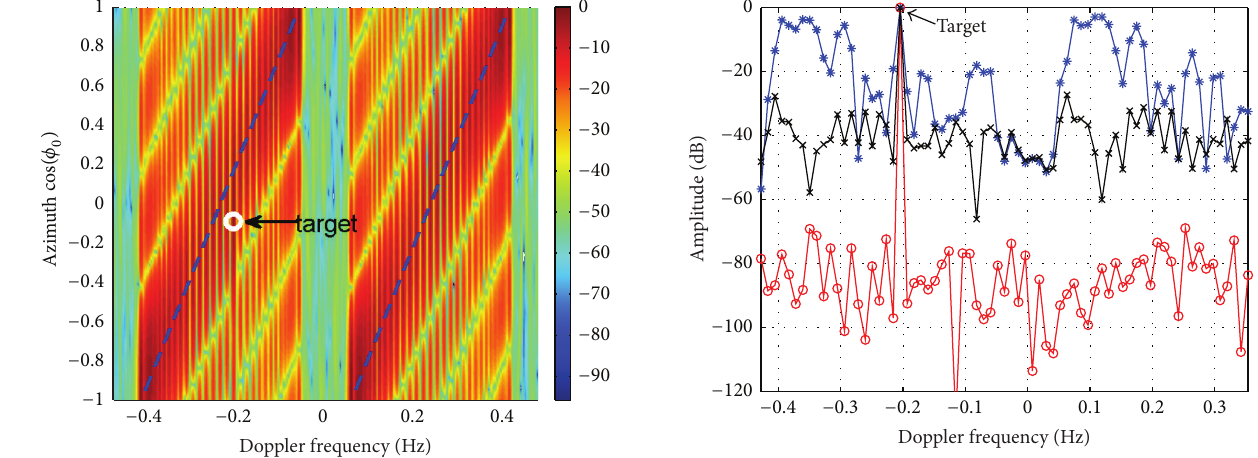
Figure 5: Space-time spectrum of simulated sea clutter plus a simulated target.